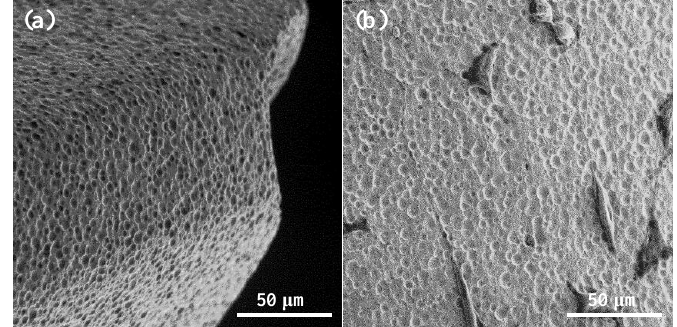
Figure 6. The cell culture of MG 63 on the anodized 316L BSS implant (5 V for 5 min) for 24 h: ( a ) the anodized surface before cell culture and ( b ) the anodized surface after cell